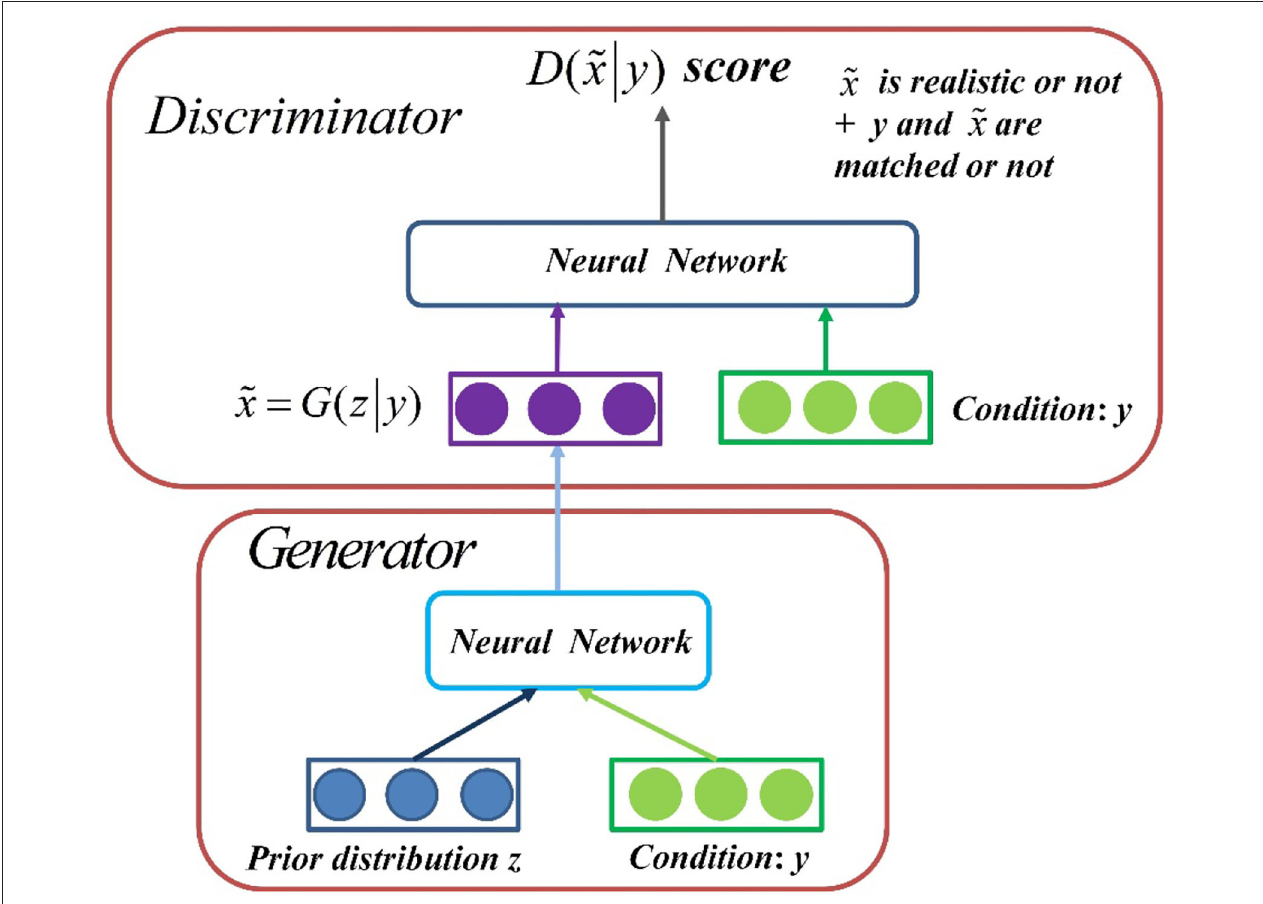
FIGURE 2 | Network architecture of